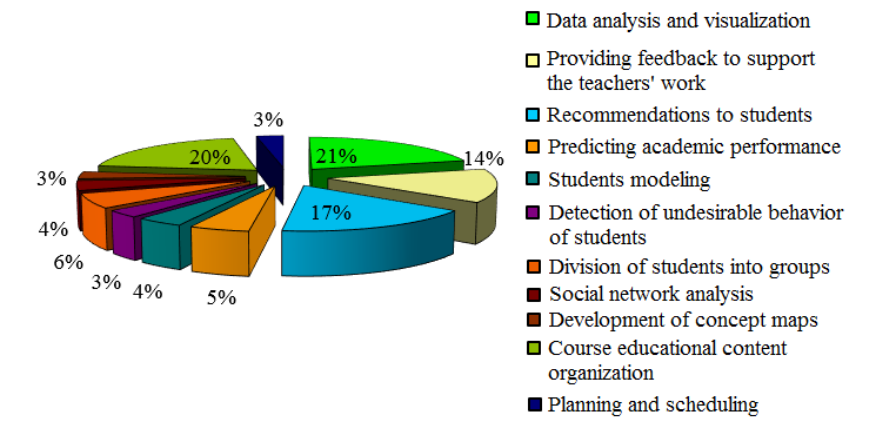
Fig. 1. The smart university infrastructure element development level